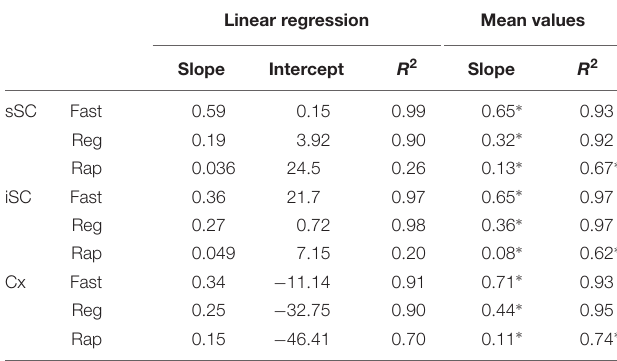
to their electrophysiological profiles. In the sSC, PV + neurons showed a variety of morphologies, stellate, narrow field vertical, and horizontal ( Figures 4A–C,E ; black bars). Wide field vertical neurons were rarely encountered. In the iSC, the predominant morphology of PV + neurons was radial-stellate, although a few horizontal neurons were encountered ( Figures 4D,E , white bars).